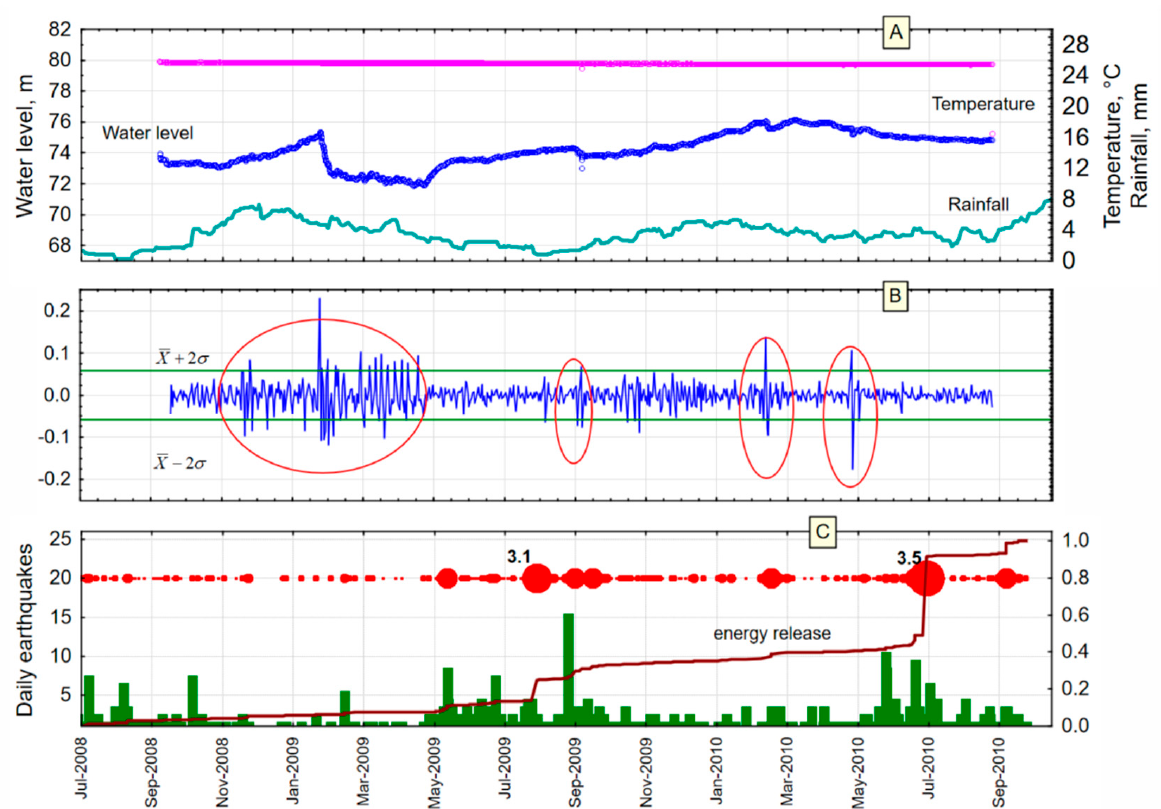
Figure 5. Water level recorded in the Mefite d’Ansanto (145 m depth) well during the September 2008 to September 2010 period. ( A ) Water level (m, left axis) and temperature (degrees Celsius, right axis) compared with the three-months rain moving average signal (rainfall data recorded in Sant’Angelo dei Lombardi pluviometric station-http://www.agricoltura.regione.campania.it/meteo); ( B ) irregular component of water level signal (processed with Census I method [32]). Anomalies are encircled by red ellipses; ( C ) seismic activity: green bars-number of daily earthquakes; red dots-seismic events with radius proportional to the magnitude; brown line-normalized cumulative curve of energy release calculated according to the relation log E = 1.5 × M L + 11.8 [33]. Seismic information from the Italian Seismological Instrumental and Parametric Database (ISIDe; http://iside.rm.ingv.it).